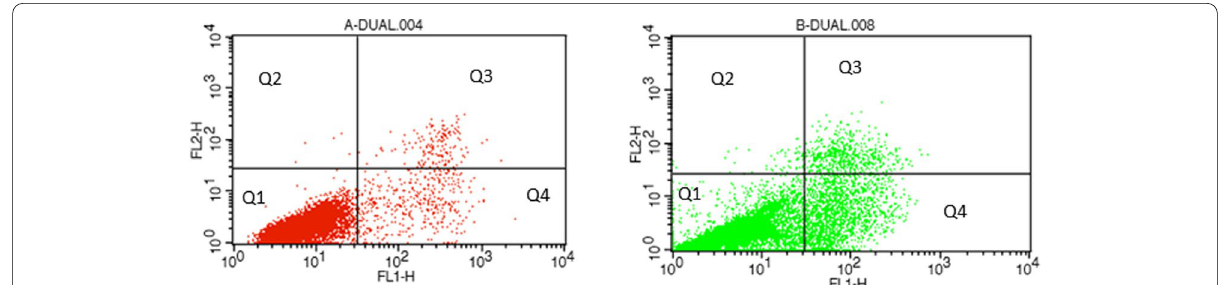
Fig. 3 Cell death induction activity of Boswellia dalzielii stem bark chloroform extract in AW8507 cell. Viable cells (Q1), early apoptotic (Q4), late apoptotic (Q3), and dead (Q2) cells. A-DUAL, 004 (untreated AW8507 cells (control)); B-DUAL. 008 (chloroform extract treated AW8507 cells)